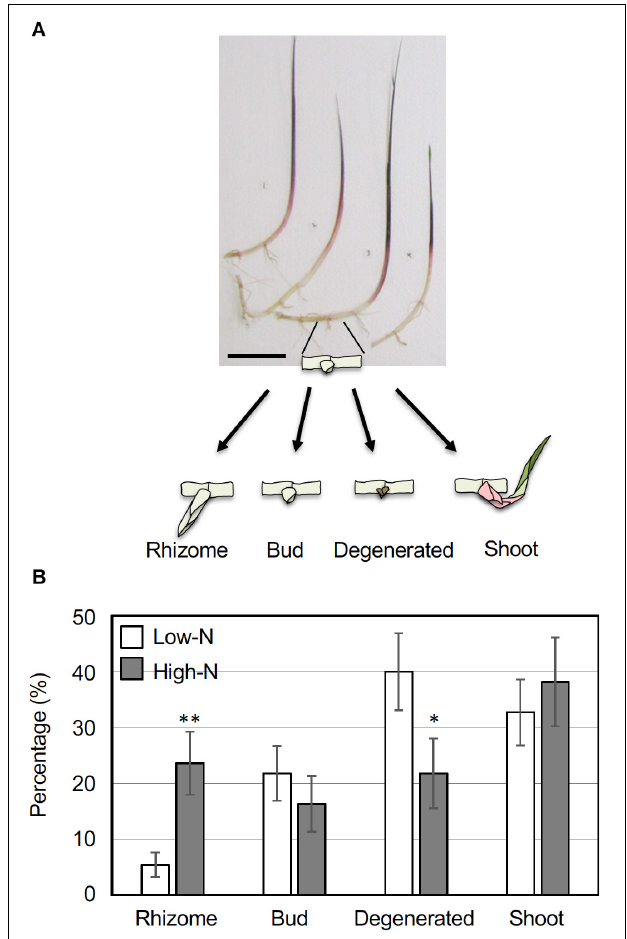
FIGURE 1 | Growth response of O. longistaminata rhizome axillary buds to nitrogen nutrition. Young ramets having rhizomes at a similar growth stage were hydroponically grown in a low-N (200 µ M NH 4 NO 3 ) medium for 2 weeks. The ramets were subsequently transferred to either a low-N or high-N (2 mM NH 4 NO 3 ) medium and incubated for an additional 2 weeks. Growth of the axillary buds on the rhizome nodes was monitored and classified into one of four categories: Rhizome (length > 10 mm), Buds (length < 10 mm), Degenerated, and Shoot. Detailed category definitions are explained in the text. (A) Typical ramets used in this experiment. Scale bar = 10 cm. (B) A comparison of rhizome growth in low-N and high-N media. Vertical bars represent the mean ± S.E. [ n (ramet) = 13 for low-N, n = 14 for high-N]. Each ramet rhizome had 2 to 7 nodes, and the total number of nodes was 55 for low-N and 55 for high-N samples. * P < 0.05; ** P < 0.01 (Student’s t test) compared to the low-N medium.